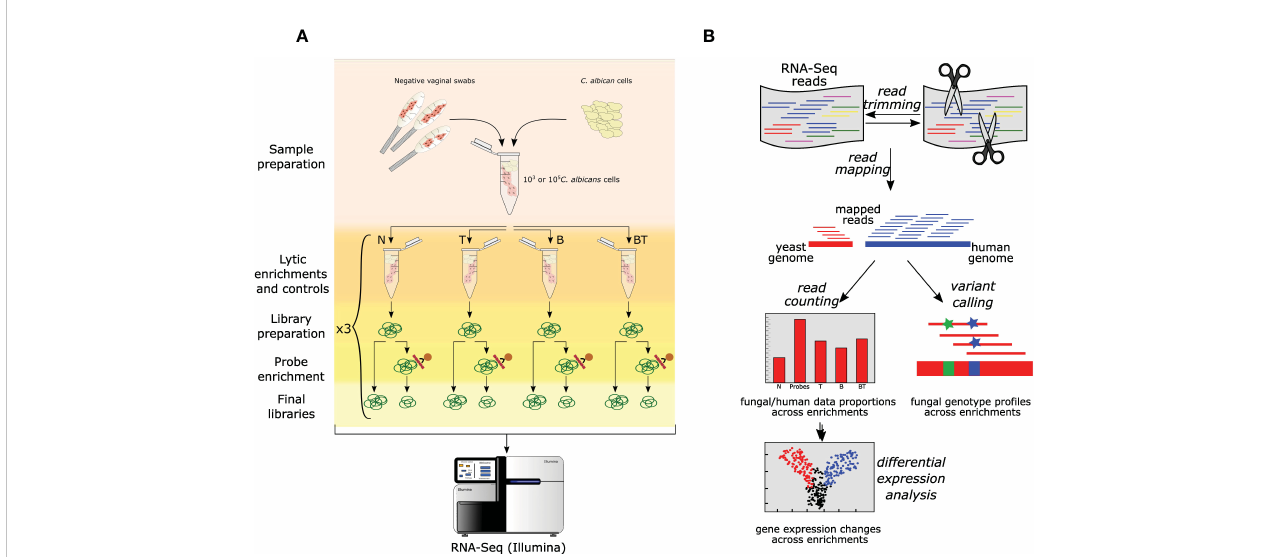
FIGURE 1 Overall experimental design and data analysis pipeline used in this study. (A) Schematic representation of the experimental setup. A pool of Candida - negative vaginal samples was spiked with different loads of C . albicans cells. Spiked samples further underwent different enrichments and sequencing. Different lytic enrichment approaches are: N - No thiolutin and no lytic enrichment; T - Thiolutin and no lytic enrichment; B - No thiolutin and buffer RLT + b -mercaptoethanol lytic enrichment; BT - Thiolutin and Buffer RLT + b -mercaptoethanol lytic enrichment. (B) Schematic RNA-Seq data analysis work fl ow employed in this study (see Materials and Methods for details).